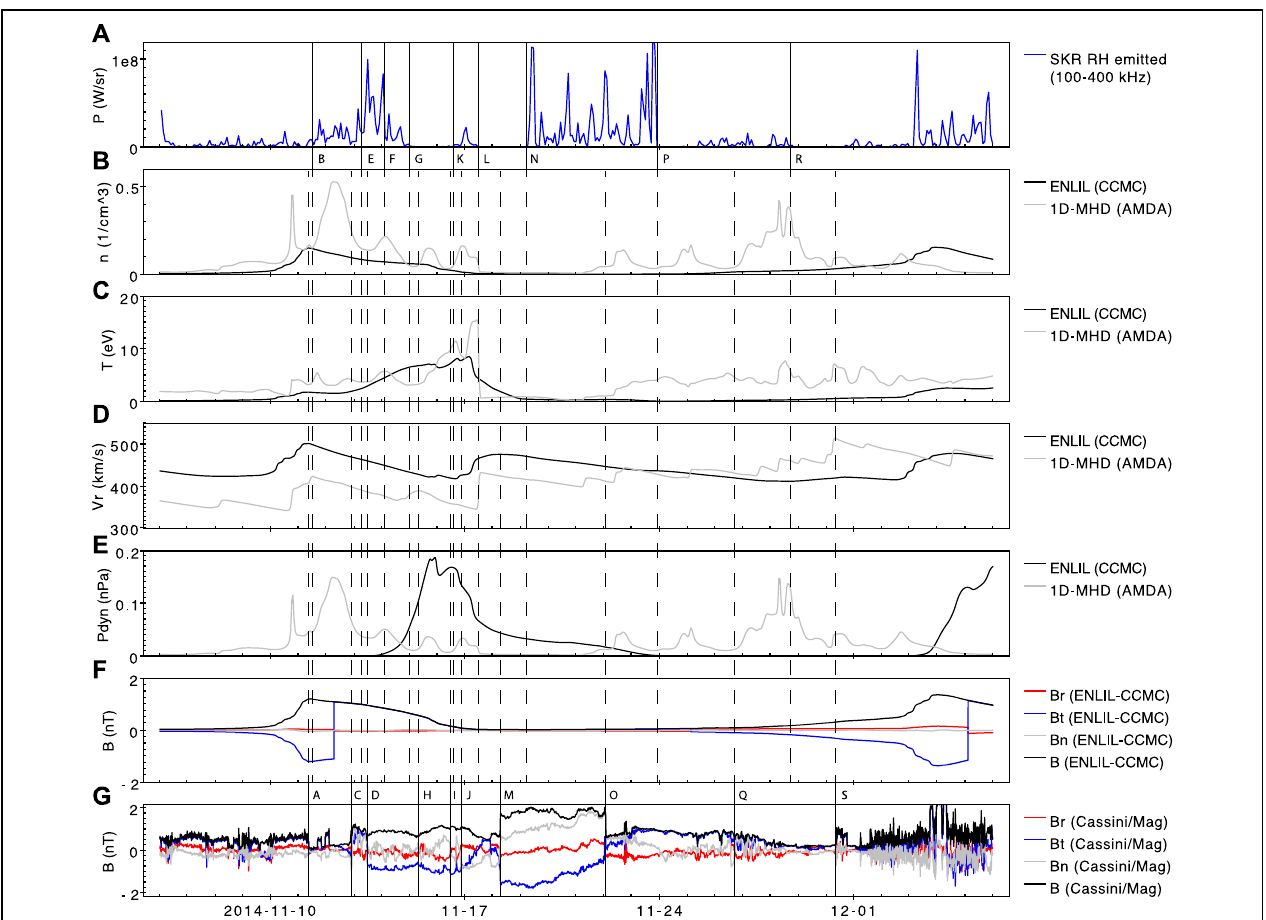
FIGURE 6 | Comparison of the solar wind modelled parameters from the two selected propagation models. From top to bottom: (A) the SKR RH emitted power density integrated over 100–400 kHz and smoothed to a temporal resolution of 6000 s; (B–E) the modelled solar wind density (in cm−3), temperature (in eV), radial velocity (in km/s) and dynamic pressure (in nPa), as provided by the ENLIL code at CCMC (black) and 1D-MHD code at CDPP (grey); (F,G) the modelled (ENLIL) and measured (Cassini/Mag) solar wind magnetic field in RTN cooordinates (Br in red; Bt in blue; Bn in grey; B magnitude in black). The vertical lines and the capital letter markers are the same as in Figure 4 and described in Table 2 . Times are given in the format YYYY-MM-DD.